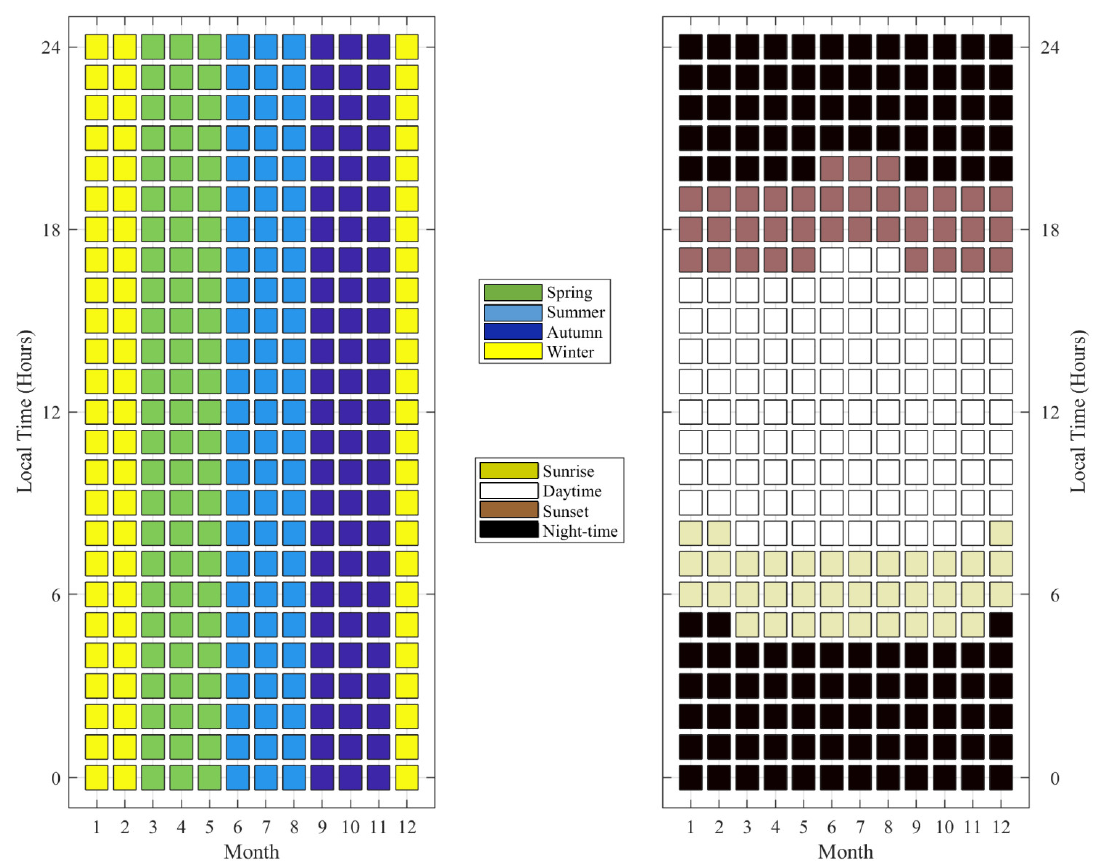
Figure 3. The period map of the whole day in four seasons.